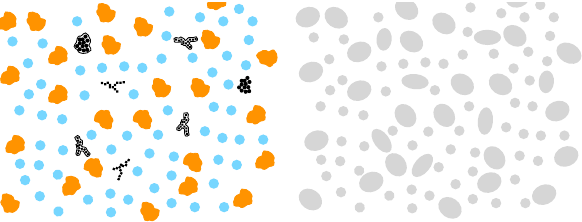
Figure 4. Left panel: a conceptual system of aerosols that contains scattering particles as well as a small fraction of absorbing carbon aggregates. Right panel: AERONET model of the same system of particles. Since all particles in the AERONET model have the same refractive index (and therefore the same color), the AERONET model disperses absorption amongst all